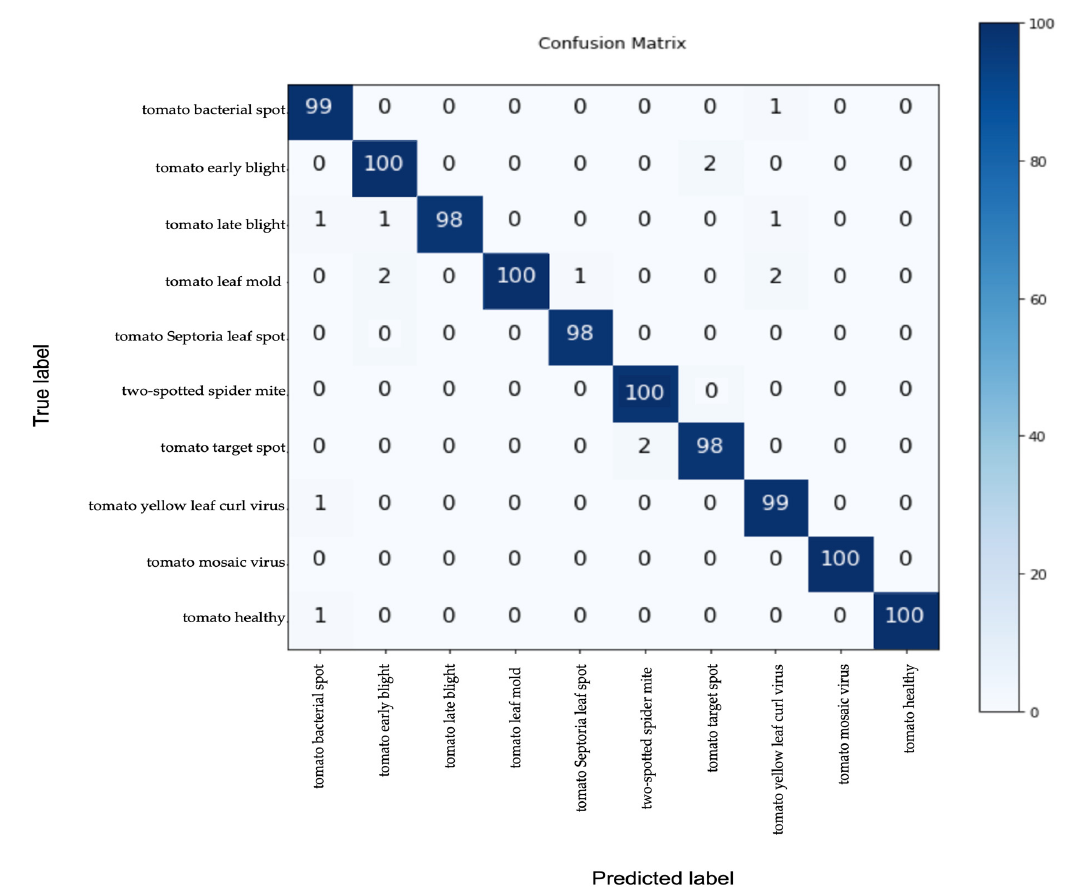
Figure 5. Results obtained of the proposed model during the training and validation phases: ( a ) accuracy and ( b ) loss.